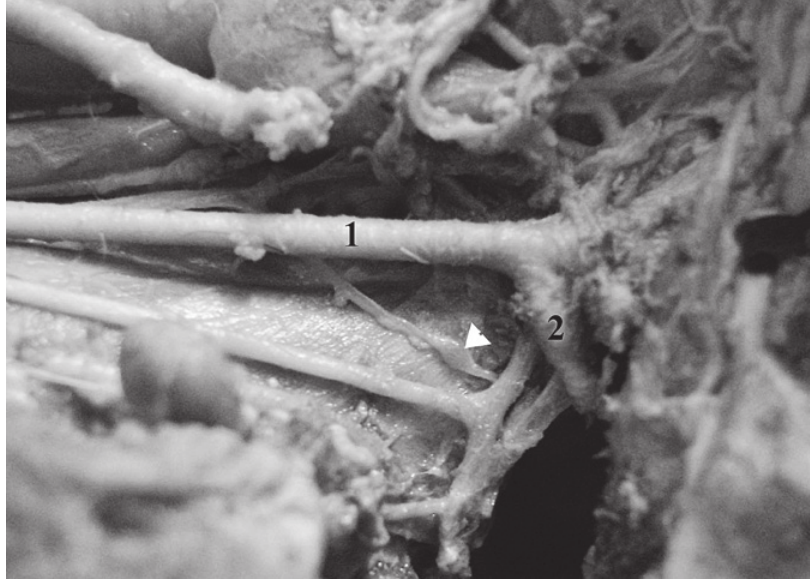
Fig 1 - Photomacrography of Saguinus niger left sympathetic trunk in lateral view demonstrating a cranial cervical ganglion (arrowhead), left common carotid artery (1) and left internal carotid artery (2) .